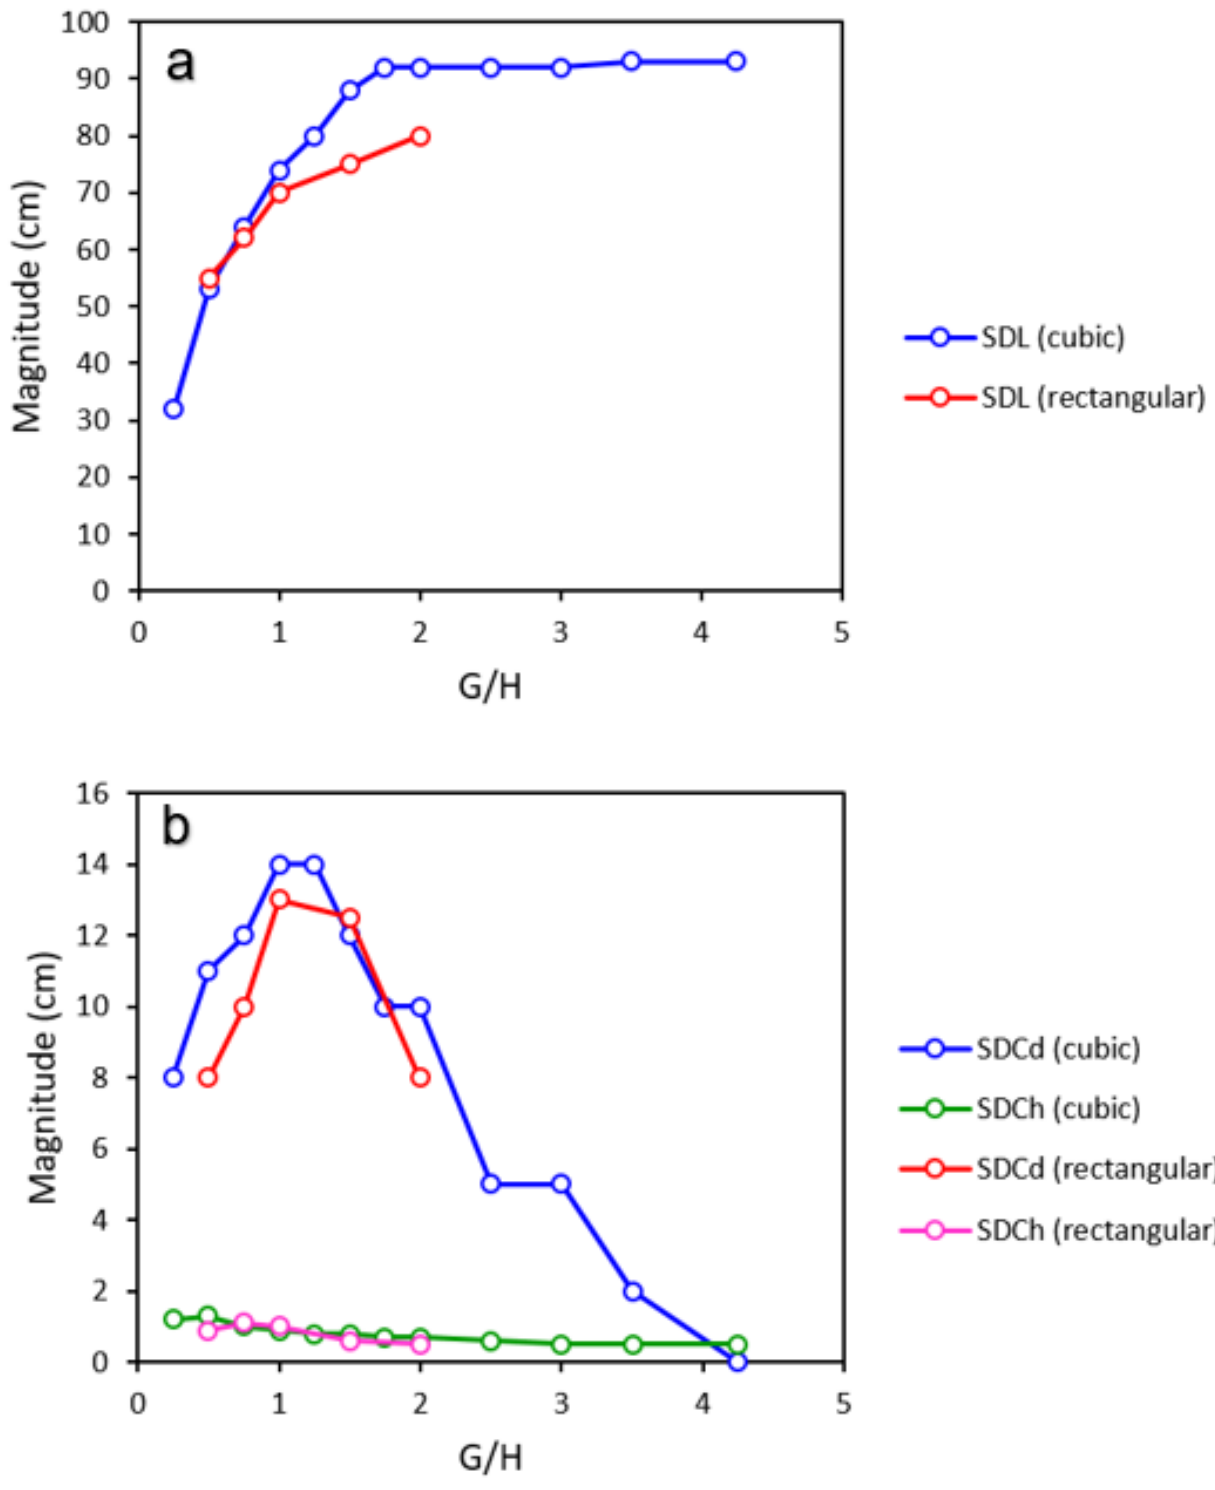
Figure 21. Effect of gap size on sand accumulation for two cubic and two rectangular-shaped buildings next to each other. ( a ) Effect on SDL; ( b ) Effect on SDCd and SDCh. (See Figure 20a for explanation of symbols).